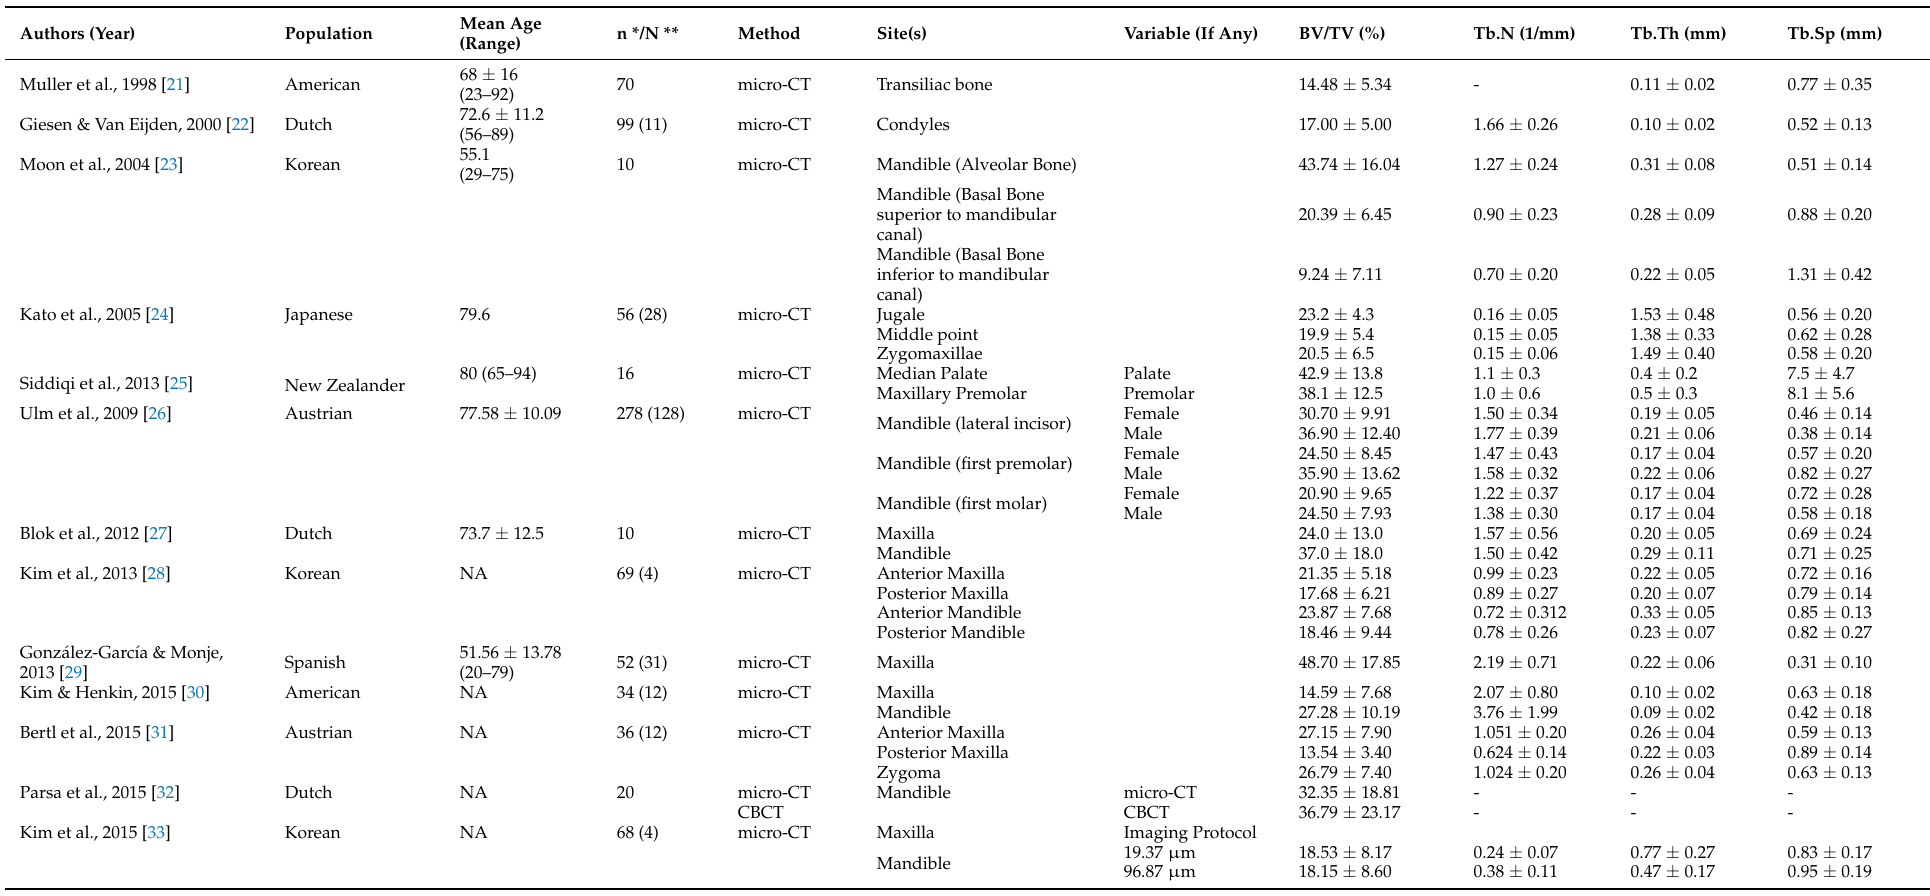
Table 3. Summary of the bony microarchitecture of various